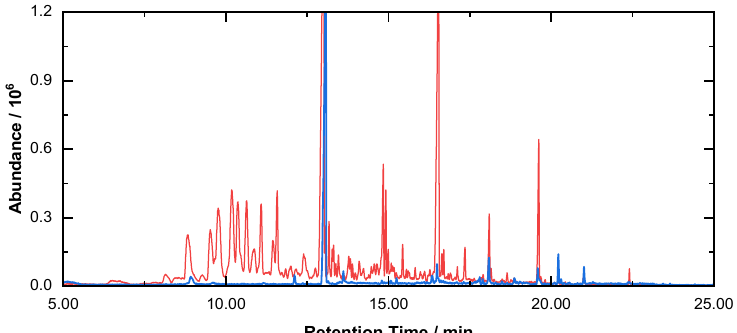
Figure 1. GCMS chromatograms of VOCs and sVOCs in the original PE stock (red) and after ~1 MGy gamma irradiation of original PE stock in water in a closed vessel (blue).